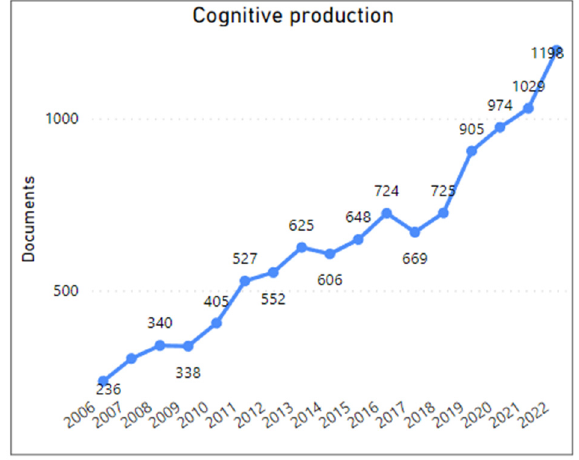
Figure 3. Cognitive manufacturing/production—years 2006–2022, 10,803 documents in period.